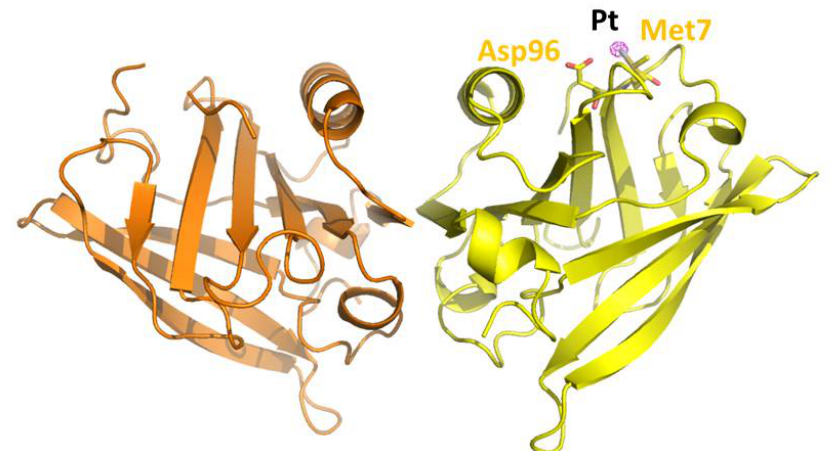
Figure 1. Overall structure of OXA/β-lactoglobulin adduct (PDB code 7NQB). The structure was obtained using X-ray diffraction data derived from crystals of β-lactoglobulin soaked for 3 days in a solution containing OXA. The Pt binding site was identified by inspecting an anomalous difference electron density map, reported in violet at a 10.0 σ level.